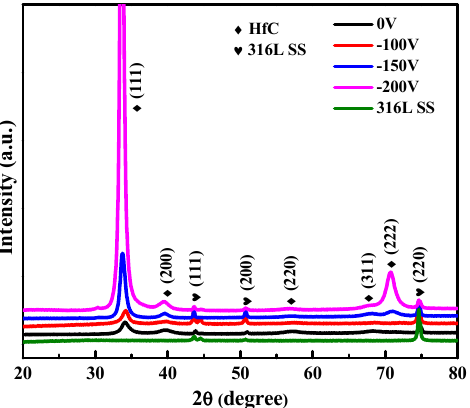
Figure 1. XRD patterns of 316L SS and HfC coatings deposited at different bias voltages.